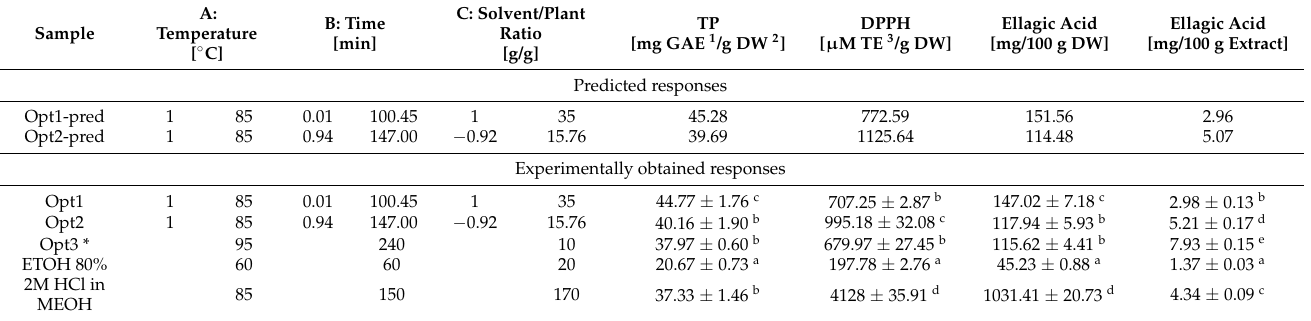
Table 5. Experimental validation of optimal conditions obtained with response surface